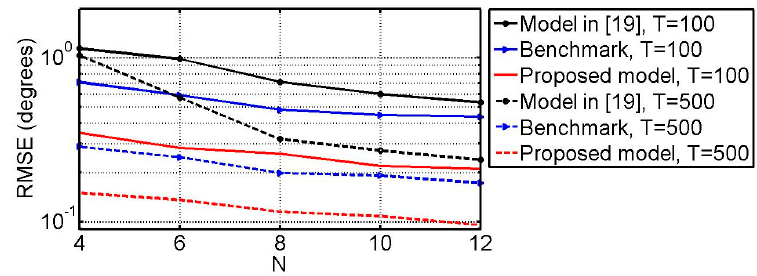
Figure 10. RMSE of the DOA estimates vs. N .